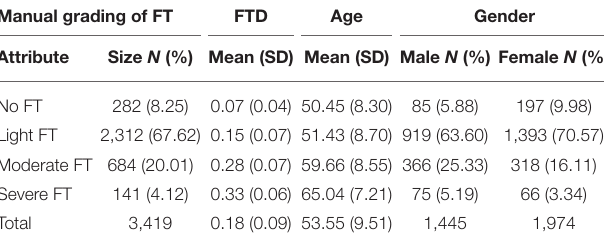
TABLE 1 | Descriptive statistics of the original sample.